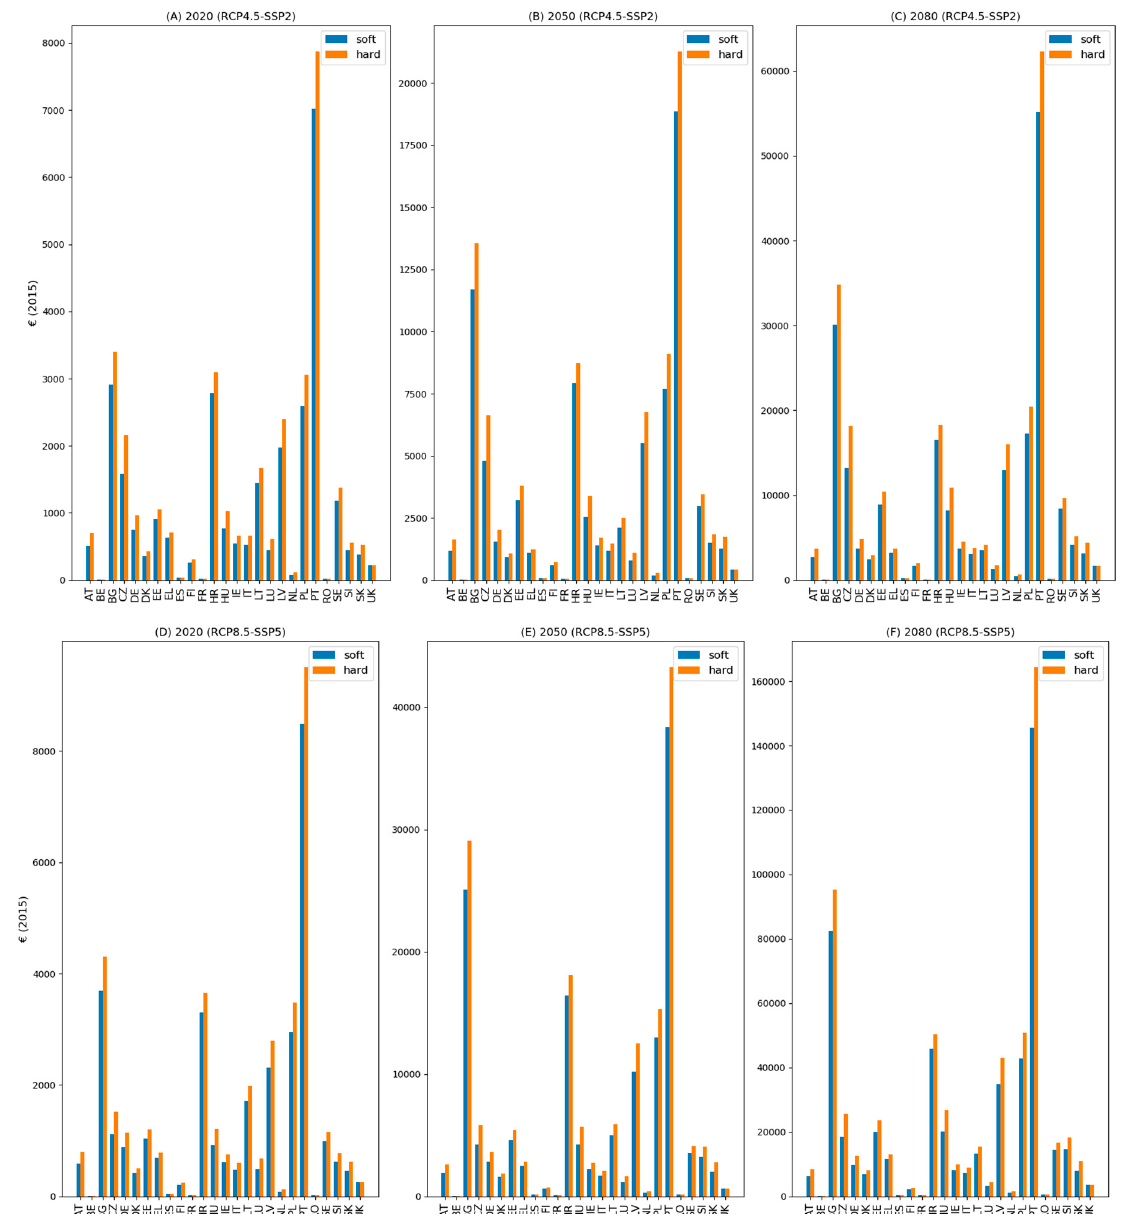
Figure 2. Average annual premiums in 2015 Euros for status-quo insurance systems in EU countries, for soft (blue) and hard (orange) reinsurance markets. Subplots A , B and C show results for 2020, 2050 and 2080, for RCP4.5-SSP2. Subplots D , E and F show results for 2020, 2030 and 2080, for RCP8.5- SSP5.